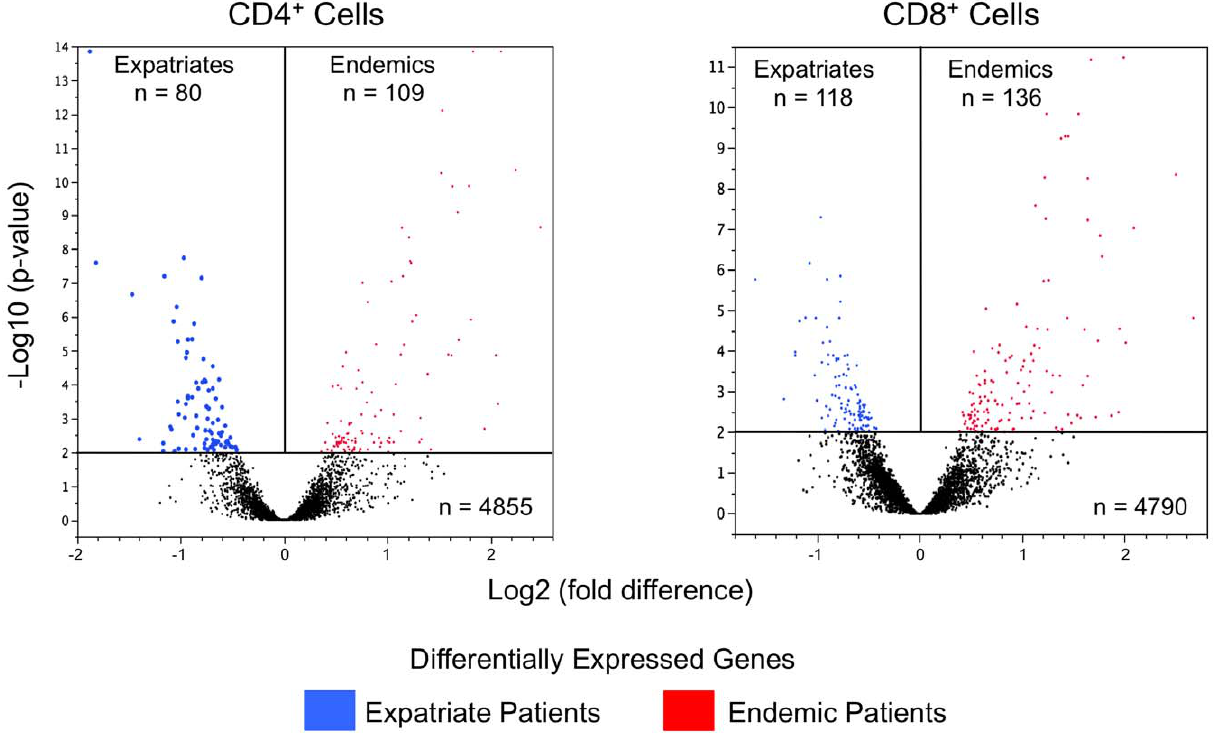
Figure 1. Volcano plots of differentially expressed genes. Volcano plots of differentially expressed genes (p , 0.01) in the unstimulated CD4 + (left panel) and CD8 + (right panel) T cells of filarial-infected expatriate (blue dots) and endemic (red dots) patients. Genes not significantly different are symbolized by black dots with each dot denoting a single gene. The x-axis is the fold difference (log 2) between patient groups and the y-axis represents the log10 of the p-value.